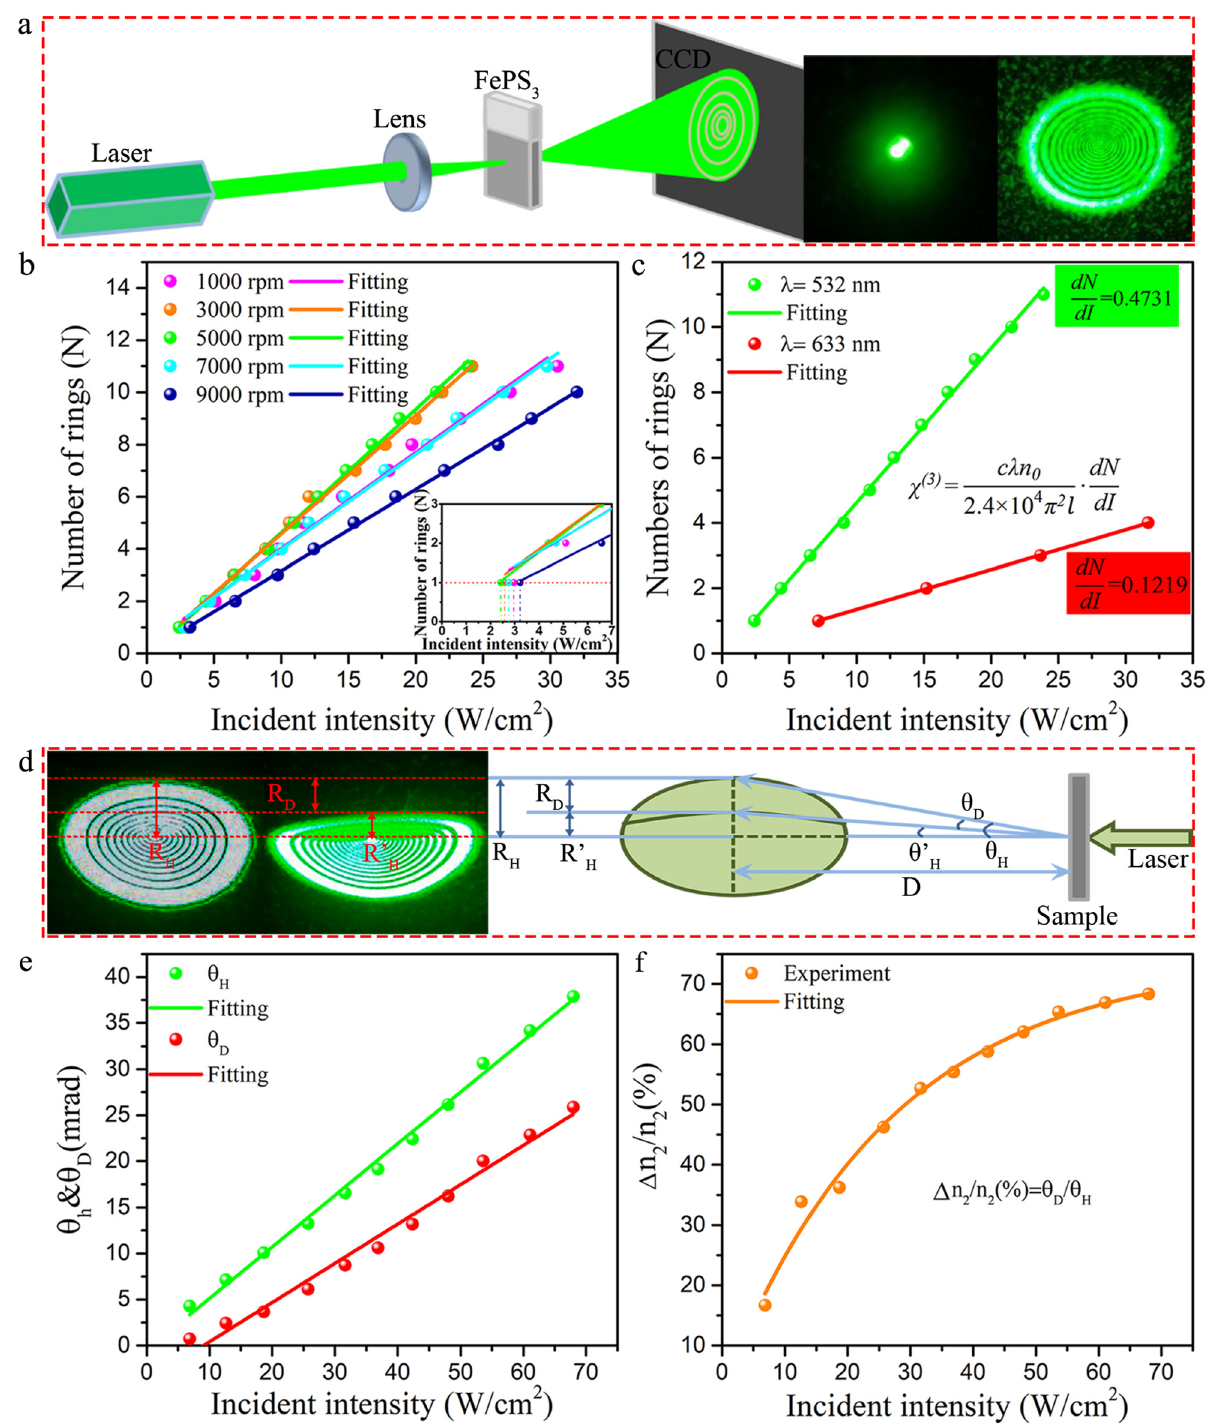
Figure 3: (a) Spatial self-phase modulation (SSPM) experiments for the iron phosphorus trichalcogenide (FePS 3 ) nanosheet solutions with experimental images. (b) Diagram of the relationship between the diffraction rings and the corresponding incident intensity for the FePS 3 dispersionobtainedfrom differentcentrifugationspeedsat λ =532nm.(c)Diffractionringsof theFePS 3 dispersionobtainedat 5000rpmas a function of the incident intensity with laser wavelengths of 532 nm (green) and 633 nm (red). (d) Schematicdiagram showing the distortion of the FePS 3 nanosheet dispersions. (e) The half-cone angle ( θ H ) and the corresponding distortion angle ( θ D ) as a function of the incident intensity at a laser wavelength of 532 nm. (f) Variation from the nonlinear refractive index of FePS 3 before and after distortion using ExpDec1 fi